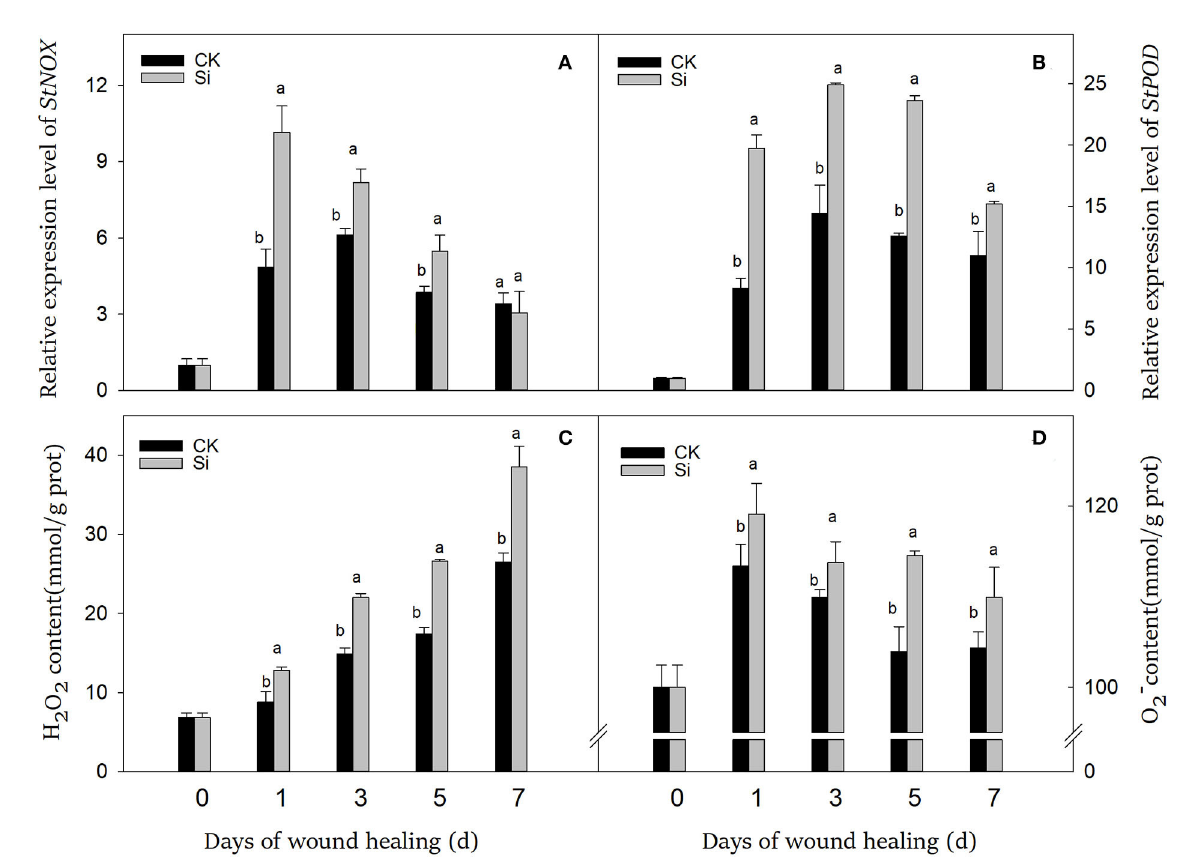
FIGURE5 Effect of sodium silicate treatment on the expression of StNOX and StPOD genes and the contents of ROS. The expression levels of StNOX (A) and StPOD (B) genes. The contents of ROS, including H 2 O 2 (C) and O − 2 (D) . Vertical bars indicate the standard error of three replicate assays. Columns with different letters at each time point are significantly different (LSD, P < 0.05).